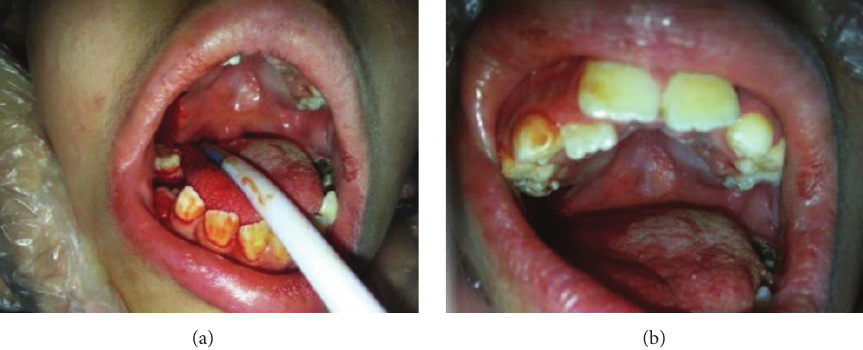
Figure 4: Newly decayed teeth were observed and a new treatment plan was established for second session of moderate